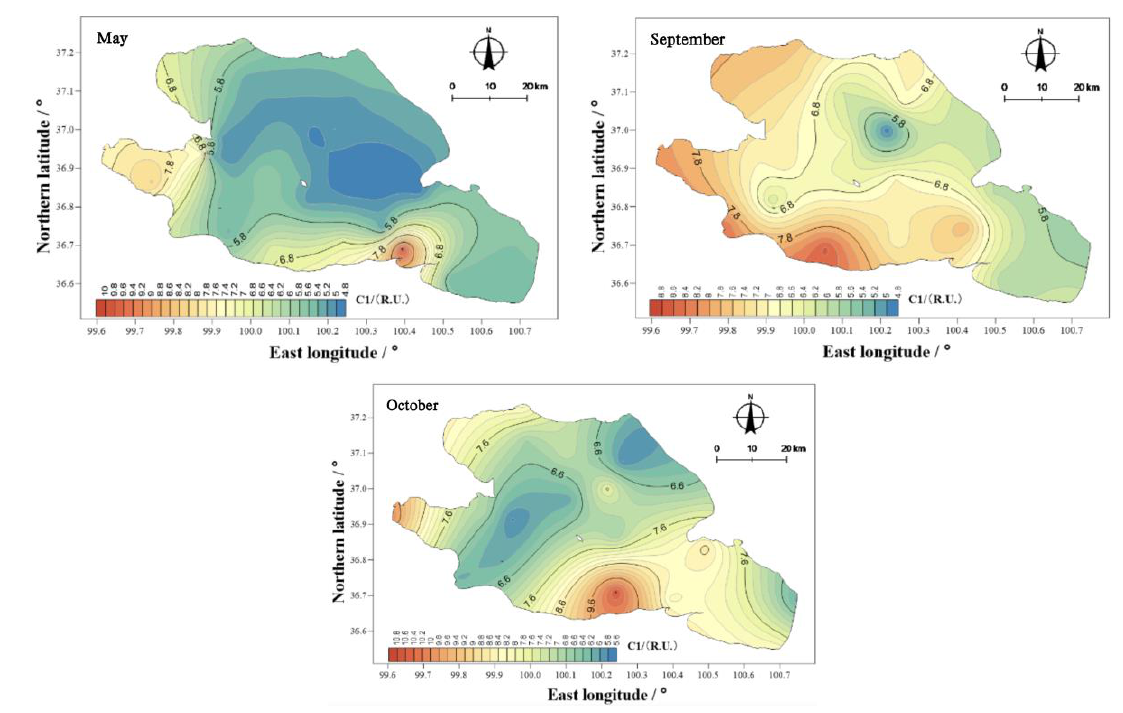
Figure 15. Spatial distribution characteristics of the fluorescence intensity of component C1 in Qinghai Lake in different seasons.